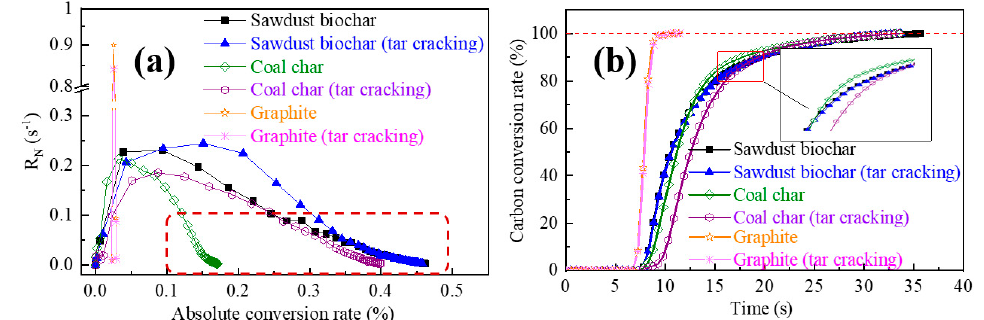
Figure 5. Reactivity analysis of char-based catalysts on in-situ biomass tar reforming from a micro fluidized bed reaction analyzer (MFBRA–MR): ( a ) Reaction rate versus absolute carbon conversion rate and ( b ) carbon conversion rate with time.